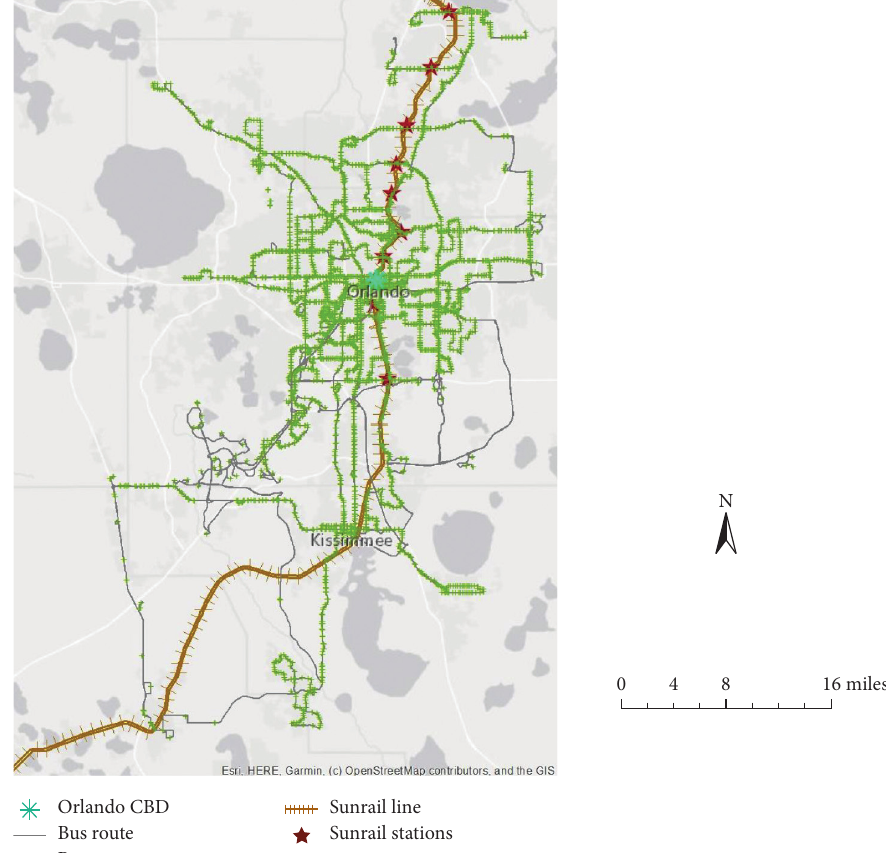
Figure 1: Public transit system (Lynx and SunRail) of